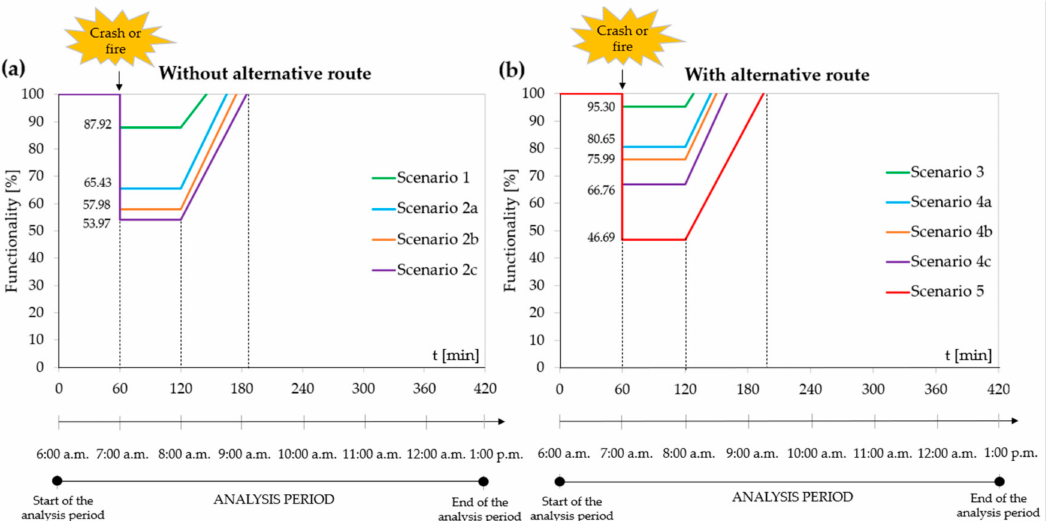
Figure 7. Functionality recovery curve of both the motorway section containing the tunnel tube investigated and the corresponding road network for the partial or complete closure of the north tube equal to 1 h: ( a ) without alternative route, ( b ) with alternative route. Scenario 1: partial closure of the north tube (only one lane is closed); Scenario 2: complete closure of the north tube and use of the adjacent one for bi-directional traffic with the traffic by-pass opening within 10 min (Scenario 2a), 20 min (Scenario 2b), and 30 min (Scenario 2c), respectively; Scenario 3: partial closure of the north tube with alternative itinerary used by HGVs only; Scenario 4: complete closure of the tube and use of the adjacent one for bi-directional traffic with alternative itinerary used by HGVs only, and traffic by-pass opening within 10 min (Scenario 4a), 20 min (Scenario 4b), and 30 min (Scenario 4c), respectively; Scenario 5: complete closure of the north tube with alternative itinerary used by all the